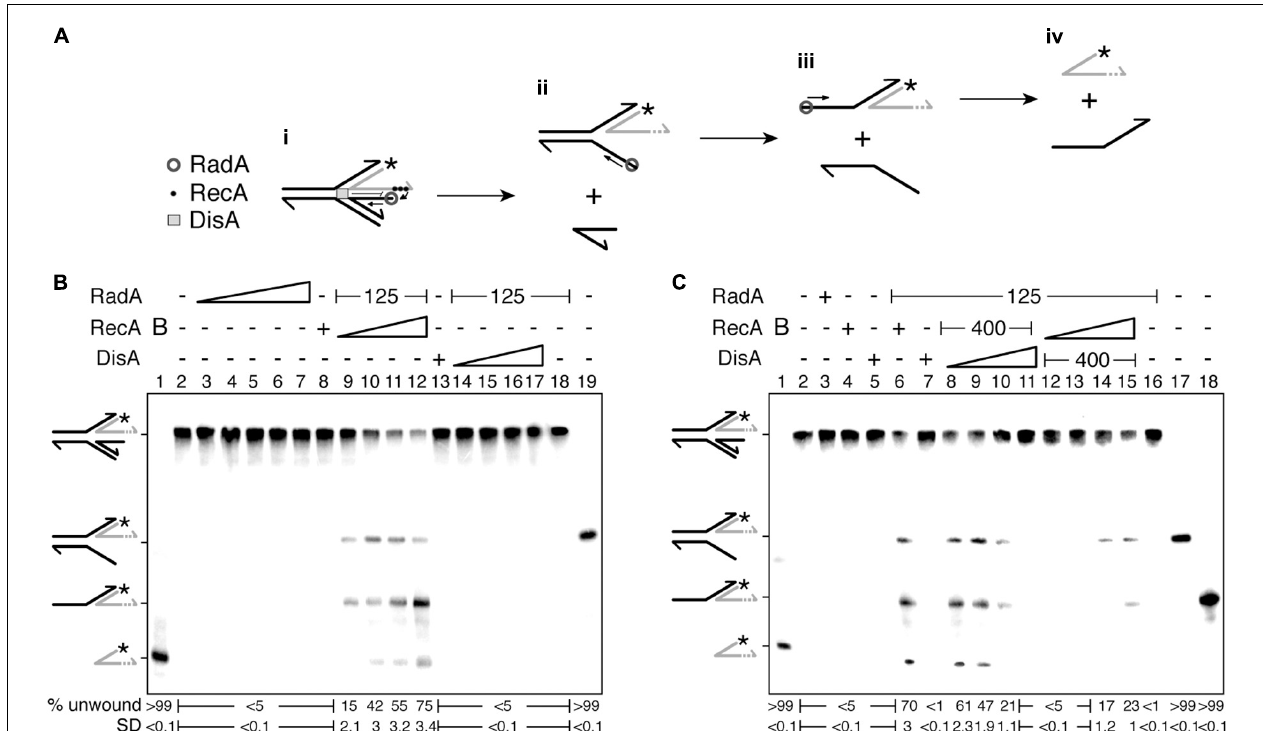
FIGURE 4 | RecA facilitates RadA/Sms-mediated unwinding of a reversed fork with a longer nascent leading-strand, but DisA blocks it. (A) Cartoon illustrating how RecA promotes RadA/Sms-mediated unwinding of 3 (cid:48) -tail HJ DNA substrate. RecA filamented at the nascent leading-strand loads RadA/Sms at the nascent lagging-strand. Then, RadA/Sms unwinds the newly synthesized lagging-strand (i,ii), originating a 3 (cid:48) -fork intermediate, that is then further processed by RadA/Sms (ii–iv). (B) 3 (cid:48) -tail HJ DNA was incubated with increasing RadA/Sms (30–480 nM) concentrations, fixed RecA (400 nM) or DisA (800 nM) concentrations, or with a fixed concentration of RadA/Sms (125 nM) and increasing RecA (50–400 nM) or DisA (100–800 nM) concentrations; and the helicase activity measured. (C) 3 (cid:48) -tail HJ DNA was incubated with RadA/Sms (125 nM), RecA (400 nM), or DisA (800 nM), or with a fixed amount of RadA/Sms (125 nM) and RecA (400 nM) and increasing DisA concentrations (100–800 nM), or with a fixed RadA/Sms (125 nM) and DisA (400 nM) and increasing RecA concentrations (50–400 nM); and the helicase activity measured. Reactions were done in buffer A containing 2 mM ATP (15 min, 30 ◦ C), and after deproteinization the substrate and products were separated by 6% PAGE and visualized by phosphor imaging. The quantification values of unwound DNA and the SD of > 3 independent experiments are documented. B, boiled DNA substrate; − and +, absence and presence of the indicated protein; * and gray color, the labeled strand; half of an arrowhead, the 3 (cid:48)